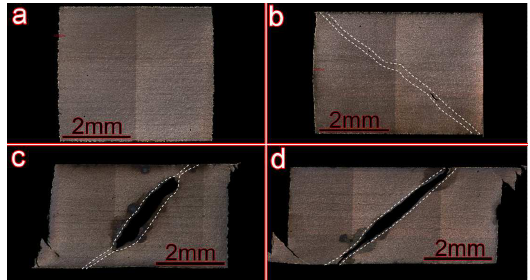
Fig. 2. macroscopic images of zirconium alloy deformed a stain rate of about 2300 s -1 : (a) stain 0.11, (b) strain 0.21, (c) strain 0.30, (d) strain 0.33.